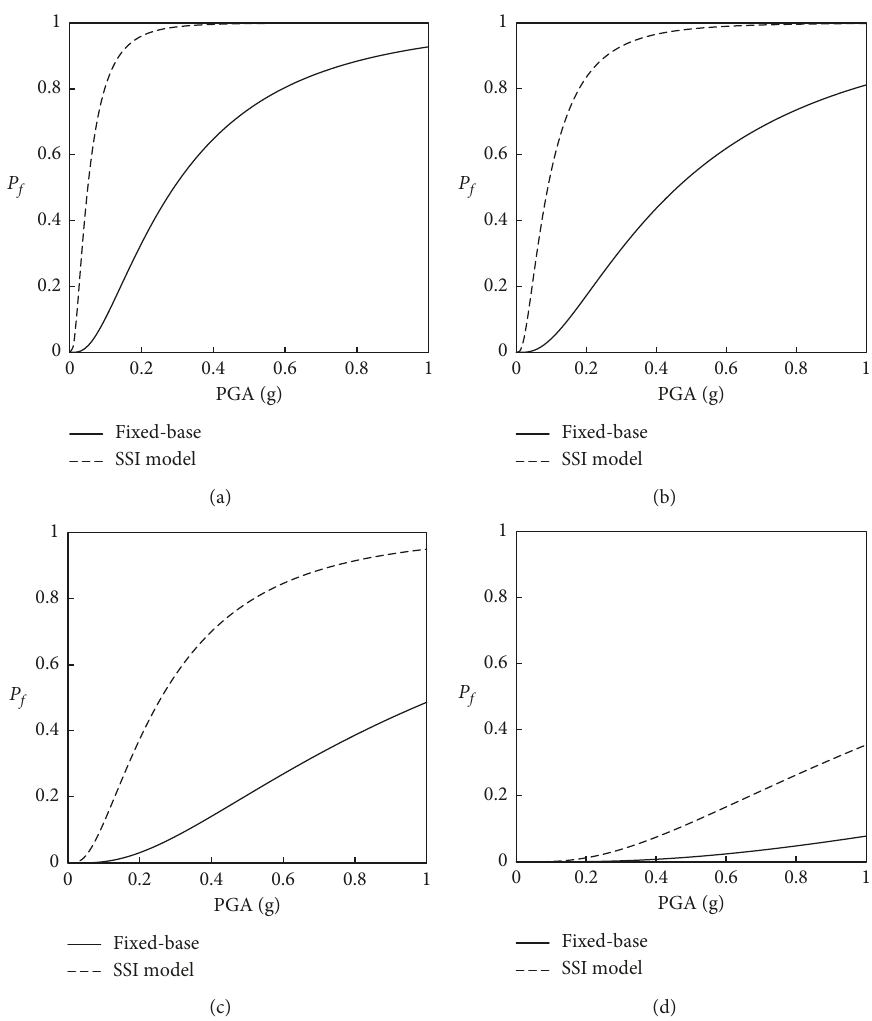
Figure 11: Comparative fragility curves between the double-parameter and single-parameter damage models: (a) slight damage, (b) moderate damage, (c) severe damage, and (d) complete